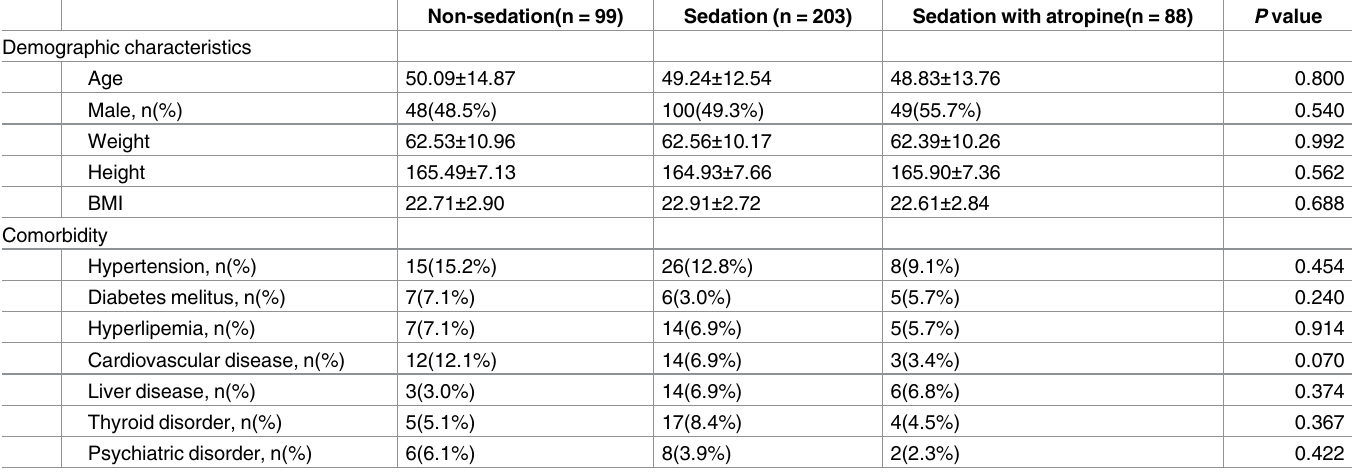
Table 1. Baseline characteristics of subjects.